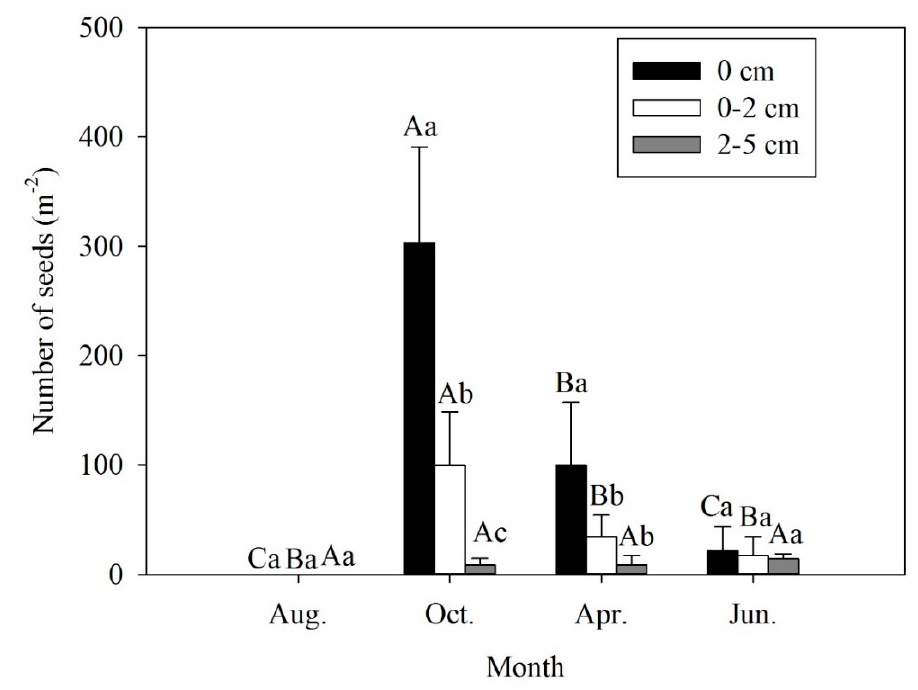
Figure 5. Dynamics of the soil seed bank of Sorbus alnifolia (Siebold & Zucc.) K.Koch in a natural habitat in 2017–2018. Error bars are mean ± se. Different uppercase letters indicate significant differences among different months within each soil depth and different lowercase letters significant differences among different soil depth within each month ( p < 0.05).